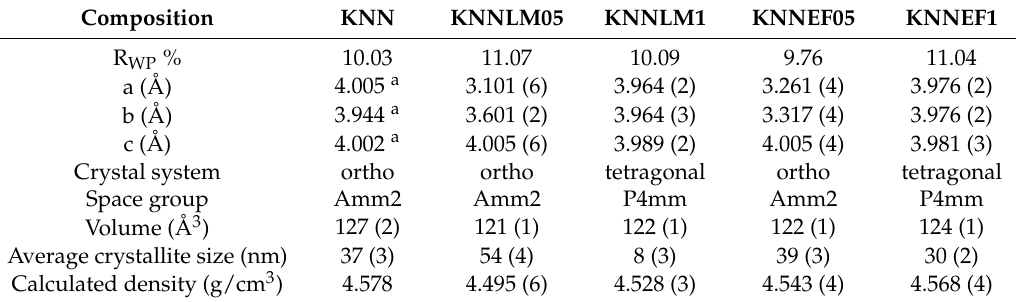
Table 1. Crystallographic parameters obtained from Rietveld refinement analysis for all solid solutions. Composition KNN KNNLM05 KNNLM1 KNNEF05 KNNEF1 R WP %